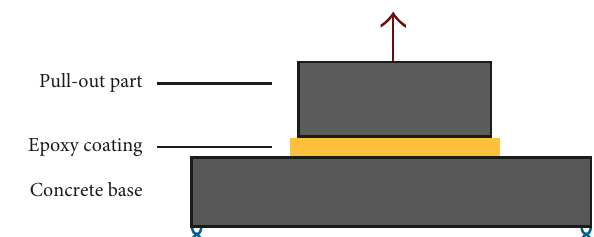
Figure 8: Sketch of the pull-out test.